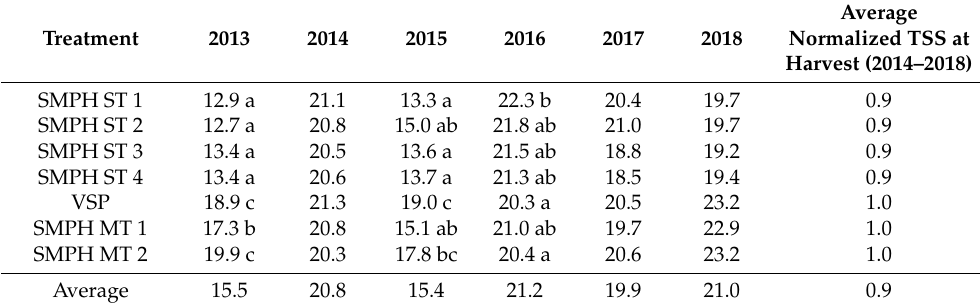
Table 5. Average values of the total soluble solids (TSS) at harvest (brix) between 2013 and 2018 as well as average normalized TSS at harvest values for 2014–2018 (value of the TSS at harvest of the respective treatment in a specific year/value of the standard treatment, VSP, in that year). TSS at harvest values of different treatments in the same year marked with the same letter did not differ significantly (according to Tukey’s multiple comparison procedure ( p ≤ 0.05)). Average (2014–2018) normalized TSS at harvest values are depicted. If no letter codes are indicated, differences were